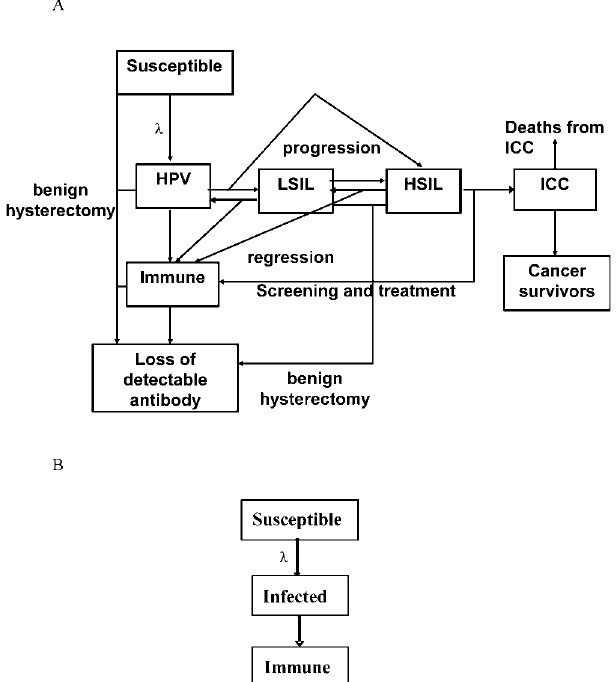
Figure 1. Model Schematic of HPV 16 Natural History in Women and Men (A) Susceptible women acquire HPV as determined by the force of infection ( k ), which is the per susceptible risk of acquiring infection. Asymptomatic HPV infection can progress to LSILs, HSILs, and ICC, although most infections regress spontaneously to an immune state. Ten percent of asymptomatic HPV progresses rapidly to HSIL. Screening and treatment can prevent progression from HSIL to ICC. The model allows for benign hysterectomy at any stage and accounts for loss of detectable antibody over time. (B) Susceptible men acquire HPV as determined by the force of infection ( k ), which is the per-susceptible-individual risk of acquiring infection from an infected woman. Infected men recover to an immune state. DOI: